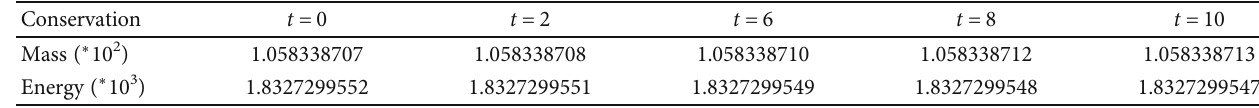
Table 3: The conservation of mass and energy for Example